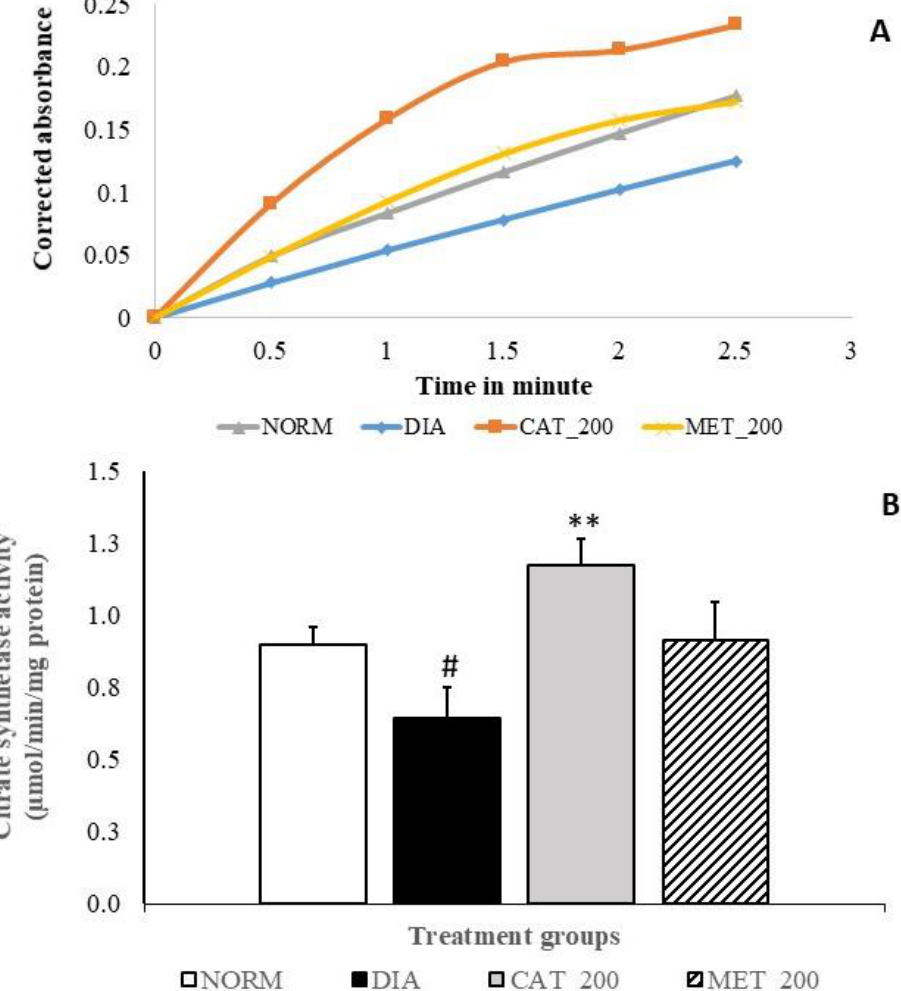
Figure 6. Effect of catalpol on CS activity in skeletal muscle ( A ) Slope of CS reaction (reaction rate) measured between 0 to 3 min ( B ) CS activity of different treatment groups. NORM: Normal control; DIA: Diabetic control; CAT_200: Catalpol (200 mg/kg; p.o.); MET_200: Metformin (200 mg/kg, p.o.). Data represents mean ± SEM ( n = 3 per group as pooled sample). # p < 0.05 vs. NORM and ** p < 0.01 vs. DIA.